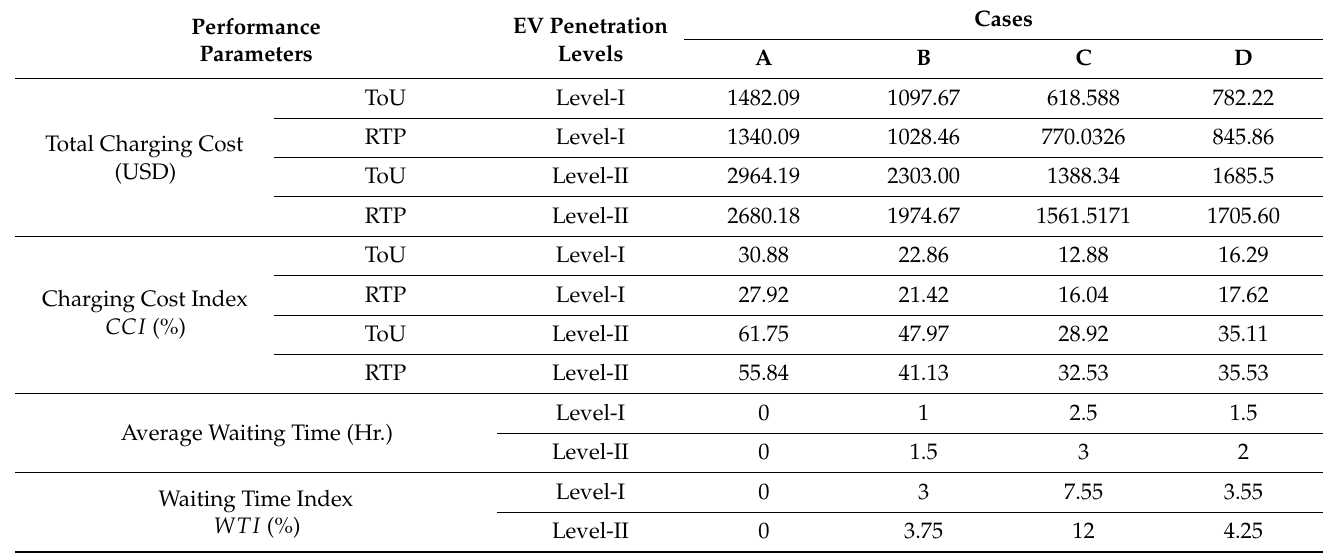
Table 5. Impact of EV charging on customer charging satisfaction for all four cases.